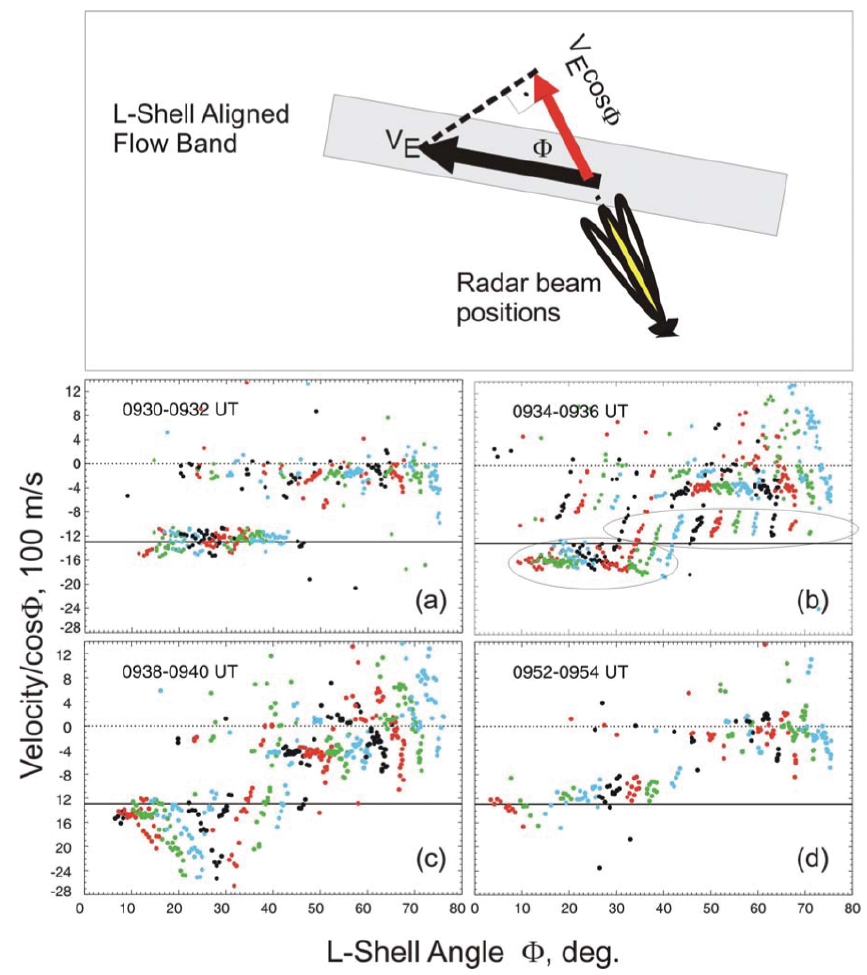
Fig. 11. Top panel: A diagram illustrating the relationship between the measured velocity in SuperDARN observations, the plasma convection velocity V E and the L-shell angle 8 . Four bottom panels: King Salmon velocity observations in various beams for four 2-min intervals on 5 December 2001 between 09:30 UT and 09:52 UT. The measured line-of-sight velocity was divided by the cosine of the L-shell angle 8 at every bin of observations. Color code was applied to various beam data as follow: black – beams 0, 4, 8, 12; red – beams 1, 5, 9, 13; green – beams 2, 6, 10, 14; and blue – beams 3, 7, 11,15. For each beam, the velocity changes with the L-shell angle. If the flows were uniform and L-shell aligned, all points would align with one line corresponding to the average velocity within the KS FoV. For illustration purposes, the line of –1300m/s is